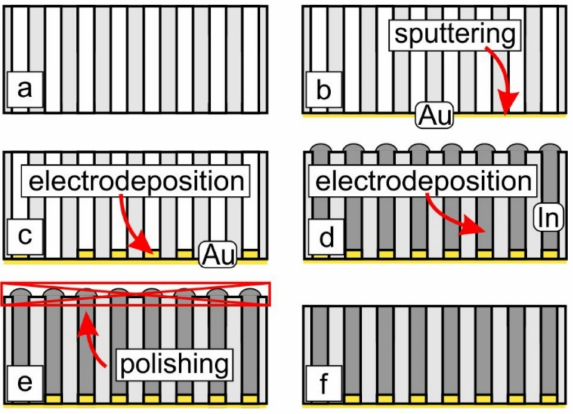
Figure 2. A flowchart of In nanowire array preparation process. ( a ) The original porous template. ( b ) Sputtering of Au layer on the porous template. ( c ) Templated electrodeposition of short Au nanorods. ( d ) Templated electrodeposition of In until complete filling of the pores by the metal. ( e ) Mechanical polishing of the top part of the nanocomposite to remove In from sample surface. ( f ) Resulting